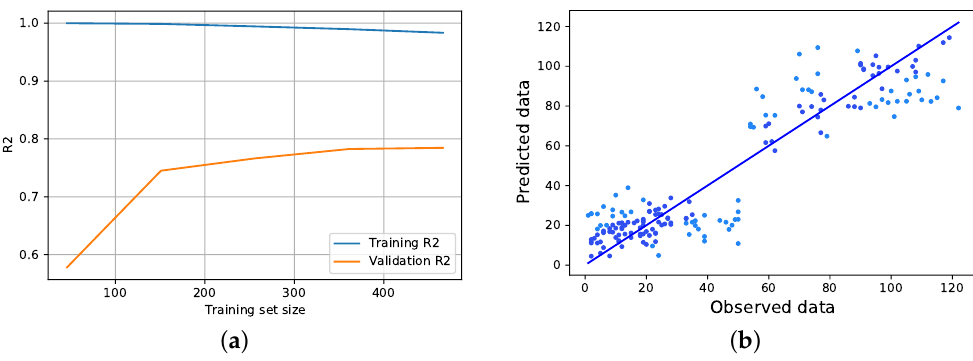
Figure 5. CatBoost Regressor ( a ) learning curve and ( b ) true vs predicted data